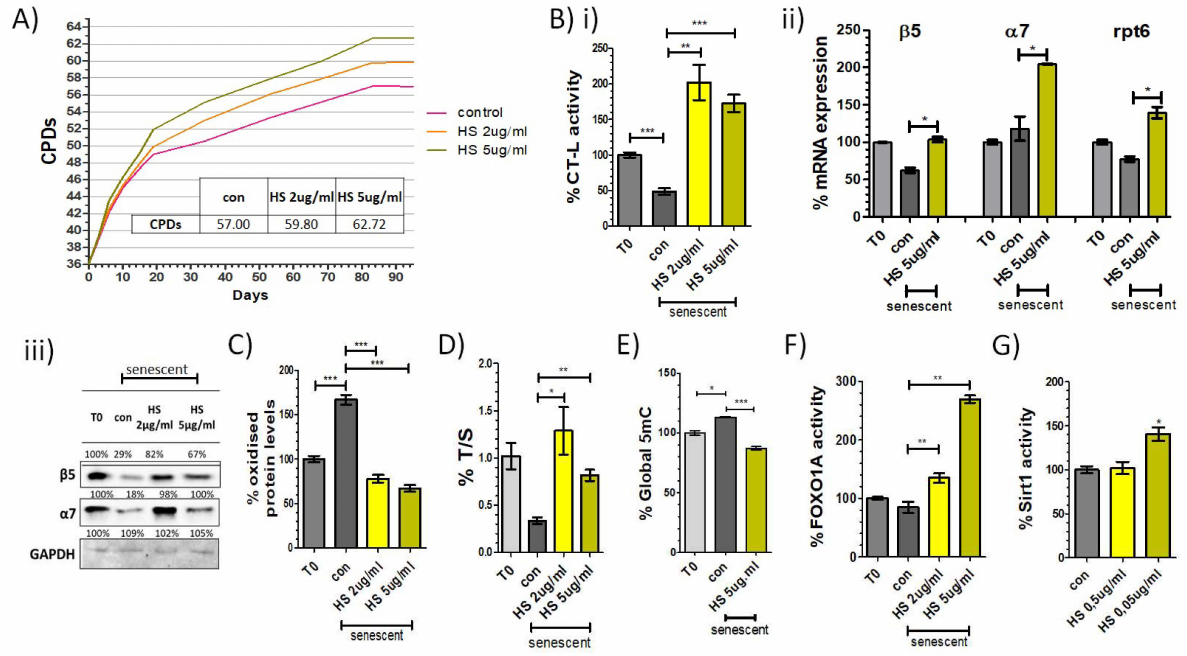
Figure 2. Antiaging and antioxidant properties of the composition in human primary cell cultures: ( A ) Number of cumulative population doublings (CPDs) of human embryonic fibroblasts